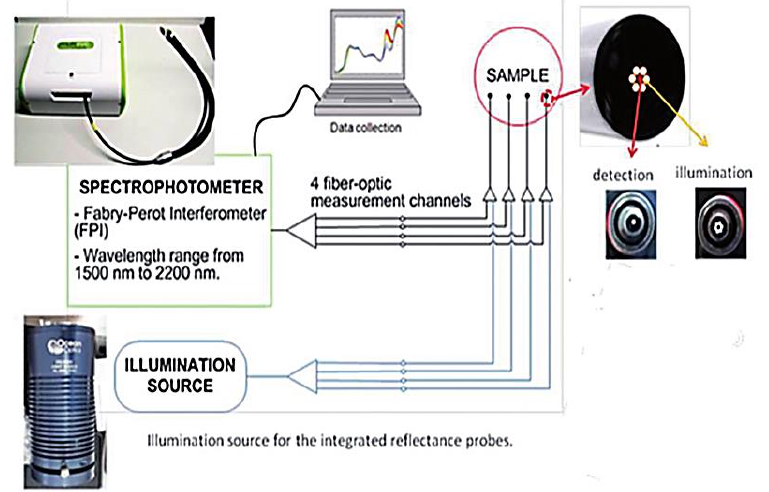
Figure 3. MultiEye® system showing NIR spectrophotometer with four channels attached to four reflectance probe fibers. Each probe fiber was attached to a detection and illumination source. Reprinted/adapted with permission from Ref. [39].